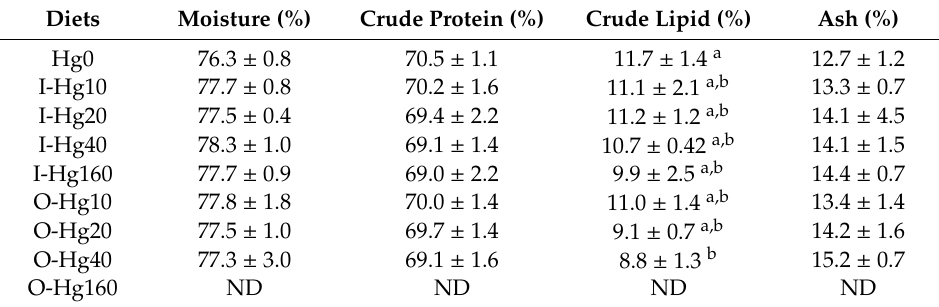
Table 3. Whole-body proximate composition of juvenile olive flounder, Paralichthys olivaceus, fed nine experimental diets for eight weeks 1